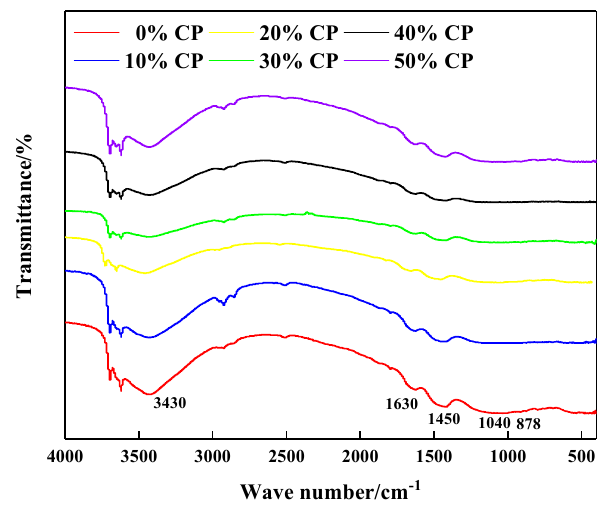
Figure 13. FTIR spectrum of CGFB samples.